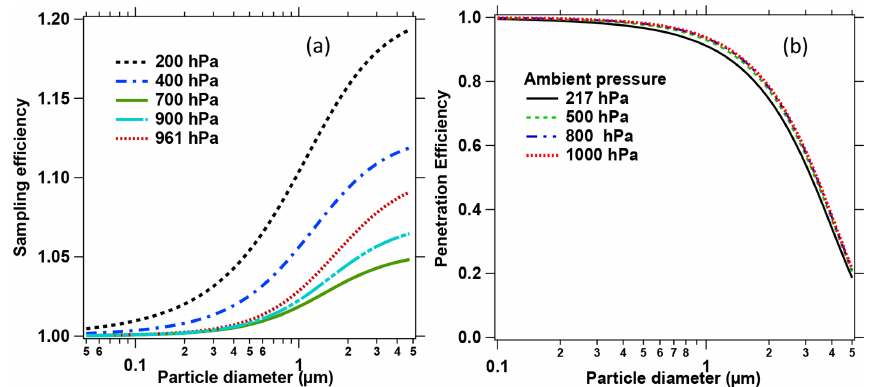
Figure 4. (a) Calculated sampling (aspiration) efficiency of the aerosol sampling inlet for five pressures encountered during ascent. The curve for 961hPa is in level flight at the bottom of a profile. (b) Calculated penetration efficiency of particles reaching the LAS instrument through the sample tubing as a function of particle